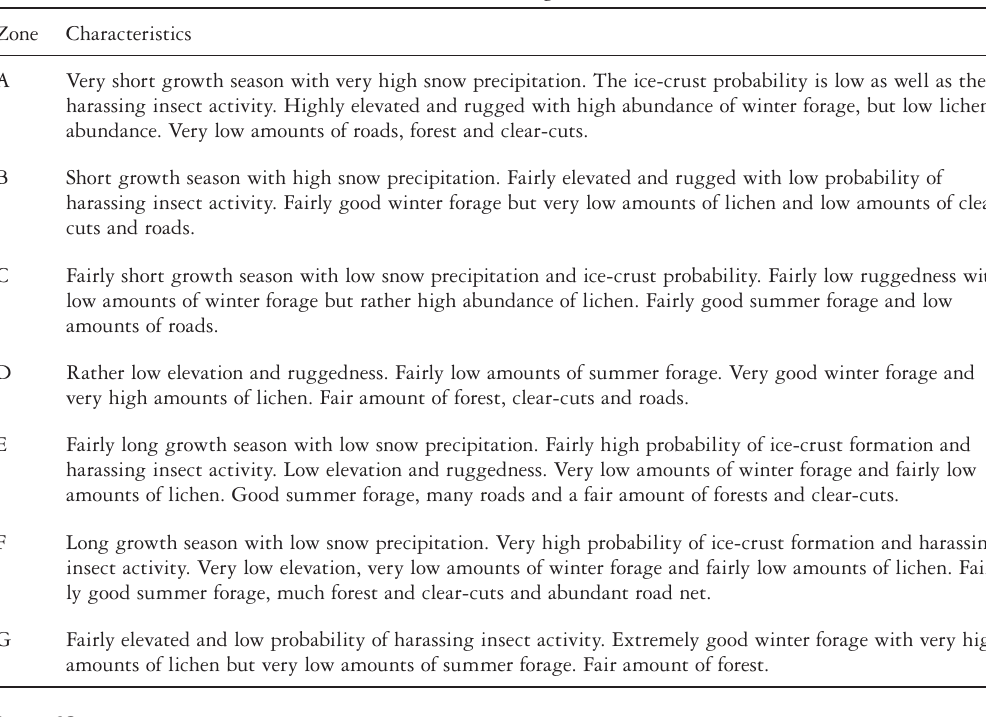
Fig. 7 . A tentative zone division of the Swedish reindeer husbandry area, based on a generalization of a cluster analysis of 15 variables ( n = 1958). The characteristics of each tentative zone are described in Table Table 5. Characteristics of the tentative zones based on averages of each zone compared to the total average of the retained 15 variables. The zone division is shown in Fig. 7.